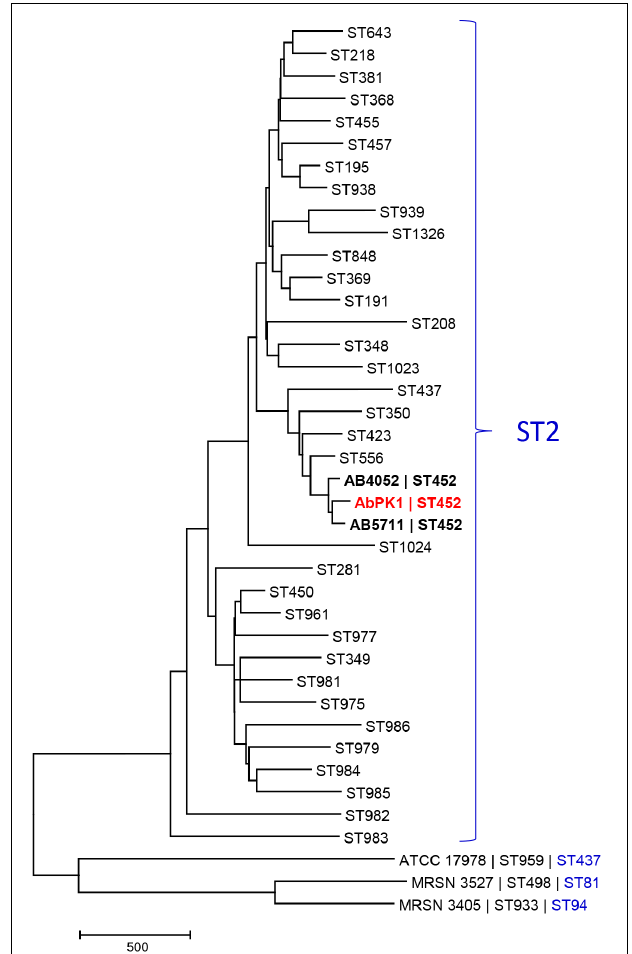
FIGURE 2 | Core genome MLST-based phylogeny of global clone 2 isolates reveals that AbPK1 represents a new lineage of ST452. The minimum evolution tree displays representative genomes of the Oxford scheme STs that correspond to ST2 of MLST scheme Pasteur (=global clone 2), and genomes of three outgroup strains ATCC 17978, MRSN 3527 and MRSN 3405. Distances between taxa were calculated as the number of loci with different allele sequences. The genome of strain AbPK1 differs from its closest relatives by diverse alleles in 134 genes (AB5711) and in 156 genes (AB4052). The ST2 taxa are displayed as “Oxford scheme ST,” the three outgroup strains are displayed as “Strain name |Oxford scheme ST| Pasteur scheme ST.” ST452 in